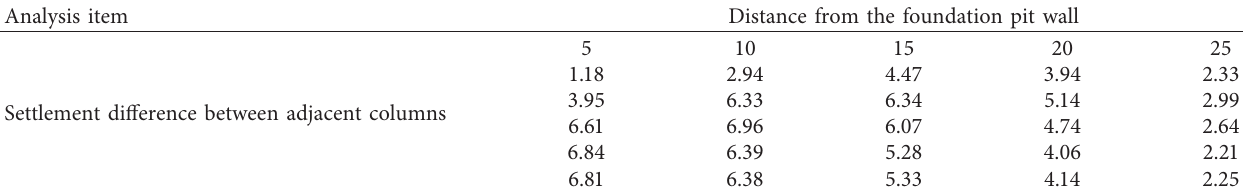
Settlement difference between adjacent columns